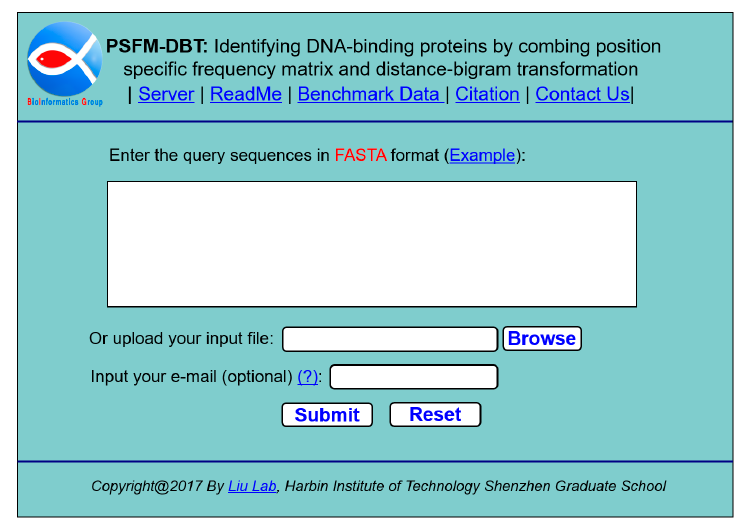
Figure 6. A semi-screenshot to show the home page of the web-server PSFM-DBT, which is available at http://bioinformatics.hitsz.edu.cn/PSFM-DBT/.